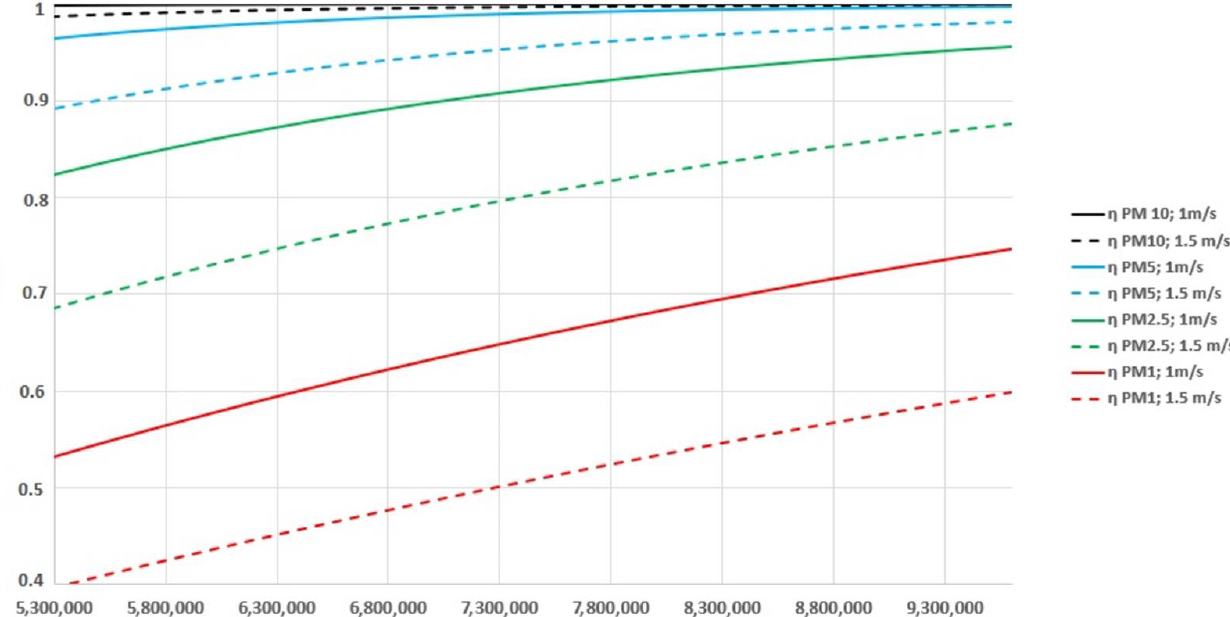
highest efficiency will be achieved with particles with a larger diameter (PM5 and PM10).